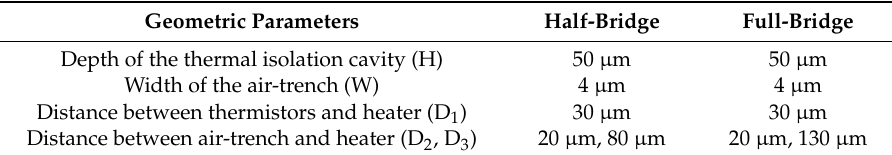
Table 1. Detailed dimensions for the gas flow